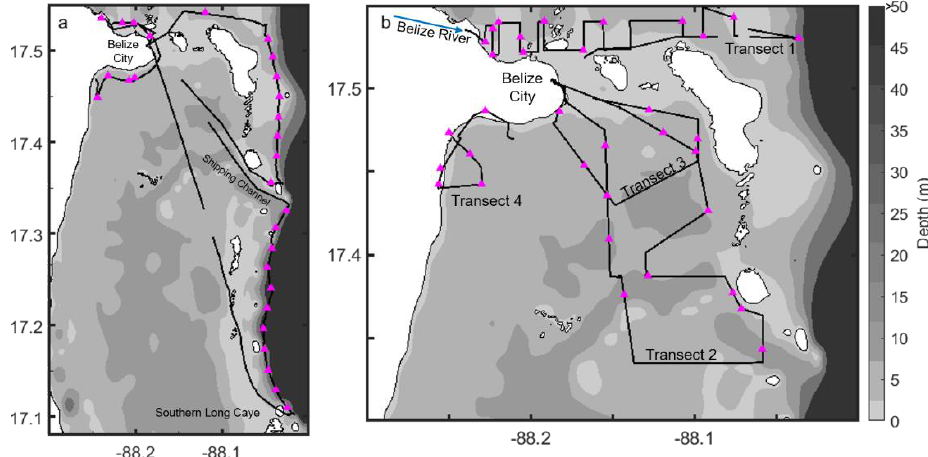
Figure 3. Location of the study site in coastal Belize with the CW4 tracks (black lines) and discrete water sampling points (pink triangles). ( a ) Deployment in November 2018 showing 3 transects, with the north–south transects conducted along the Belize Barrier and around Belize City. ( b ) Deployment in October 2019 with 4 transects, showing shorter range, but increased spatial variability characterisation.